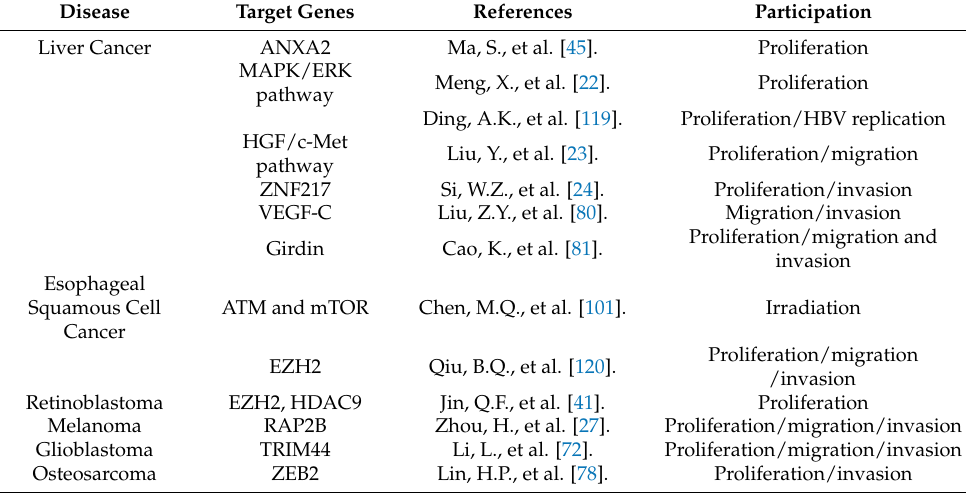
Table 1. Cont. Disease Target